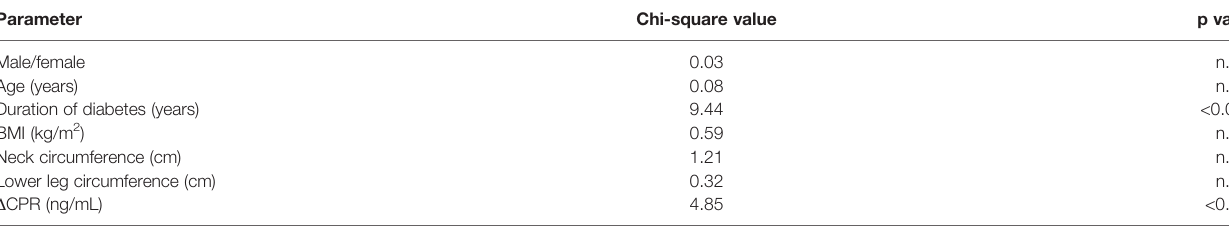
TABLE 4 | Independent factors predicting withdrawal from insulin therapy in logistic regression